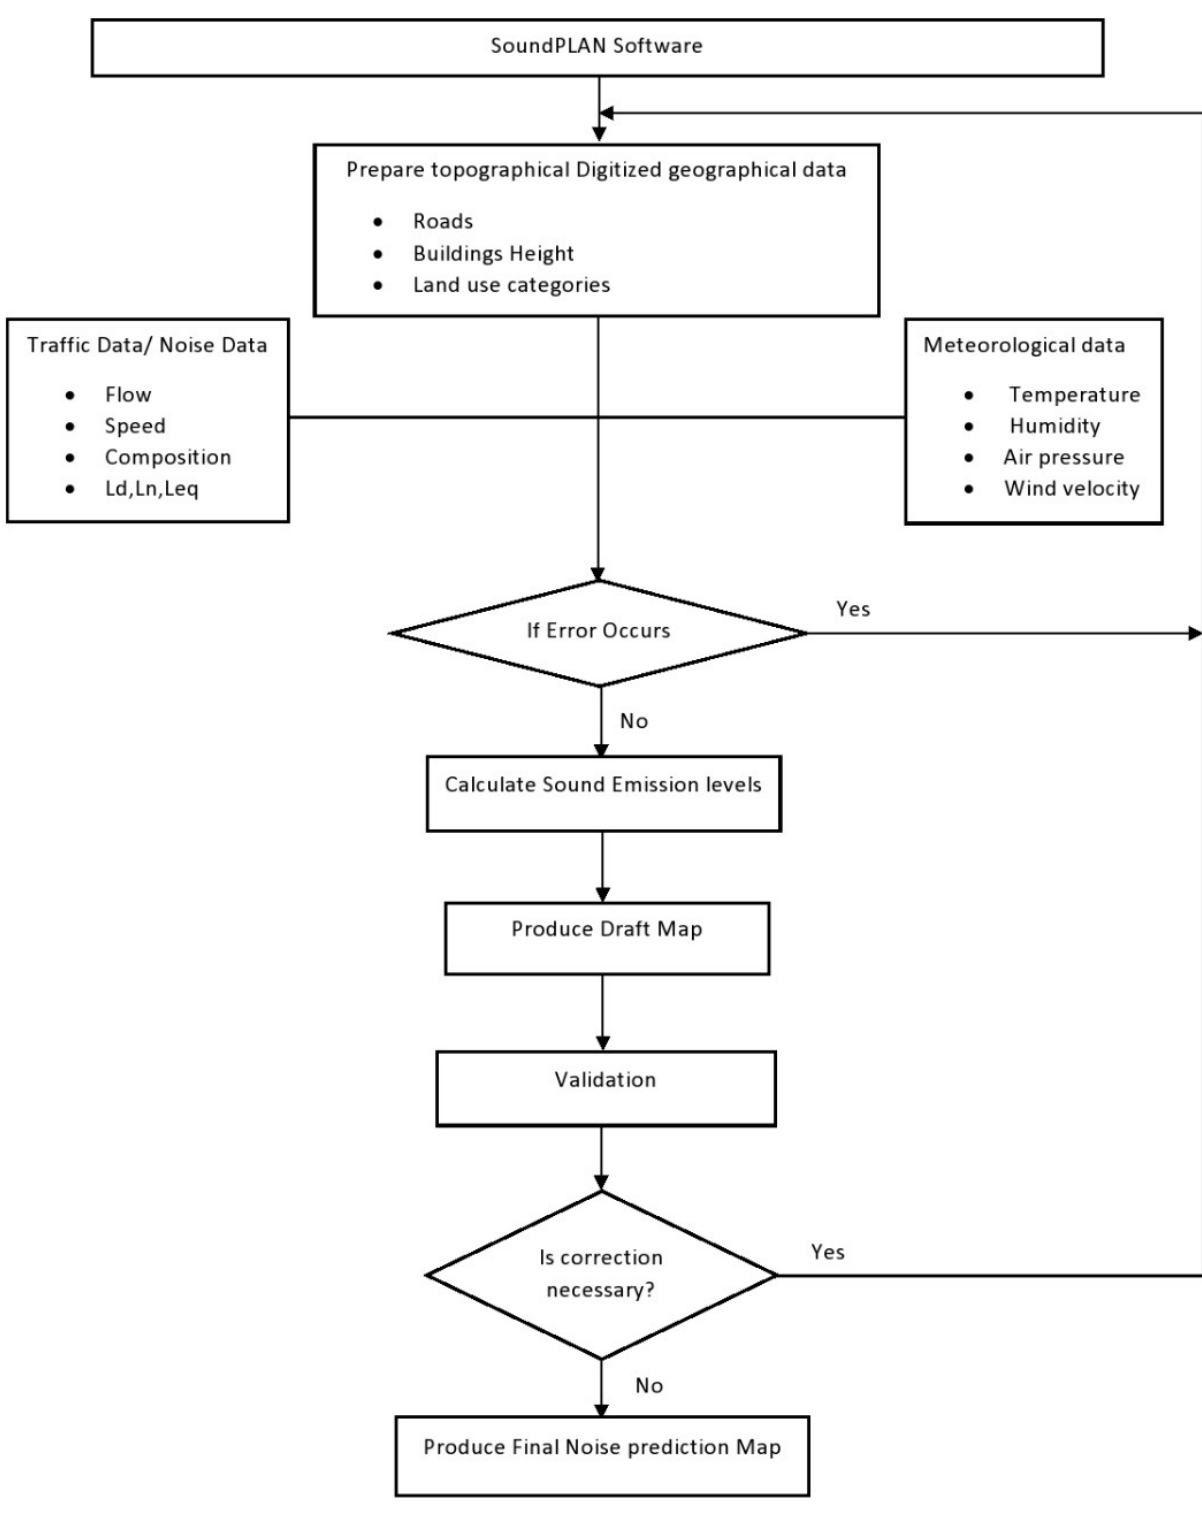
Figure 4: Methodology for noise